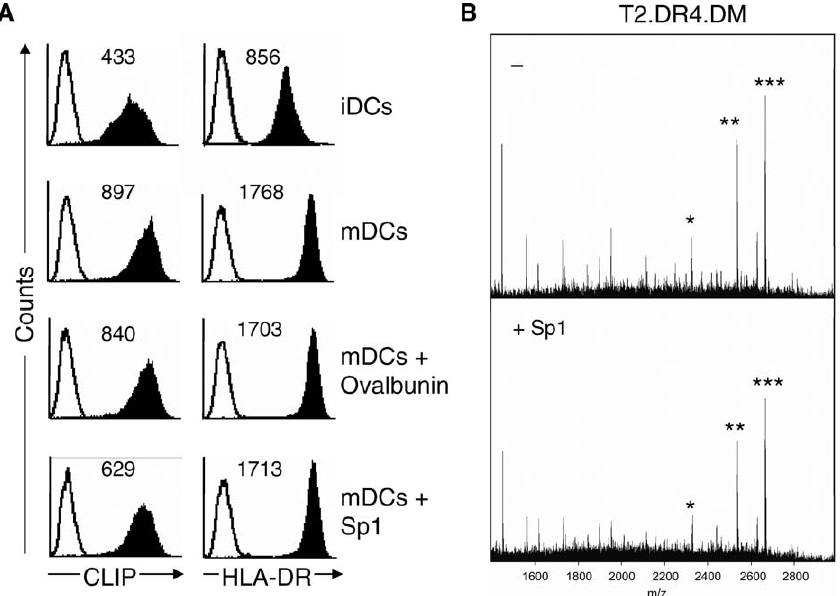
Figure 5. Effect of Sp1 on Self-Peptide Presentation (A) Flow cytometry analysis of iDCs, mDCs, ovalbumin (200 l g/ml)–treated, and Sp1 (200 l g/ml)–treated mDCs stained for CLIP and HLA-DR. Solid lines indicate the isotype-stained controls. The MFI is indicated in the upper corner. (B) MALDI-MS analysis of self peptides derived from T2.DR4.DM transfectants, without and with Sp1 treatment (200 l g/ml). MHCII HLA-DR molecules were precipitated with mAb L243. * indicates CLIP(81–102) m/z ¼ 2333.4; **, CLIP(81–103) m/z ¼ 2543.4; and ***, CLIP(81–104) m/z ¼ 2674.5.